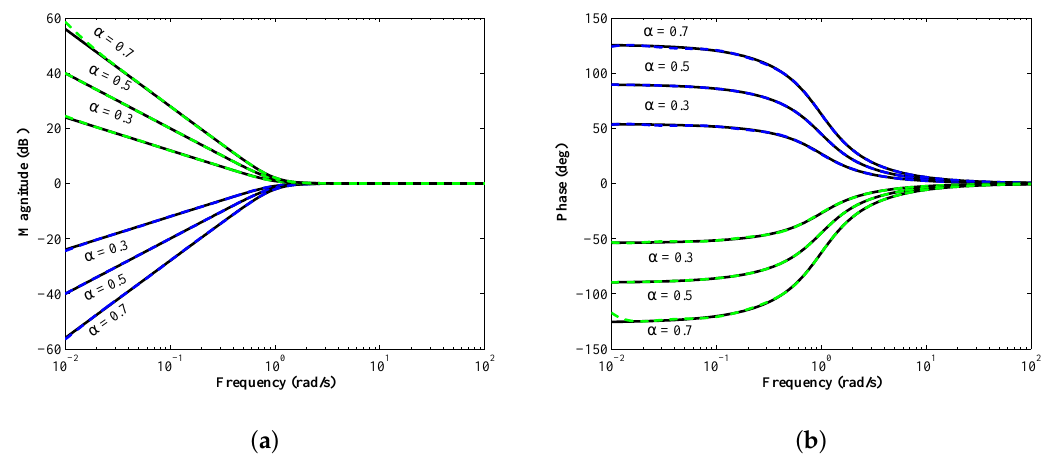
Figure 4. ( a ) Magnitude and ( b ) phase–frequency responses of the proposed HPPLFs (dashed blue) and IHPPLFs (dashed green) as compared to the theoretical ones (solid black).